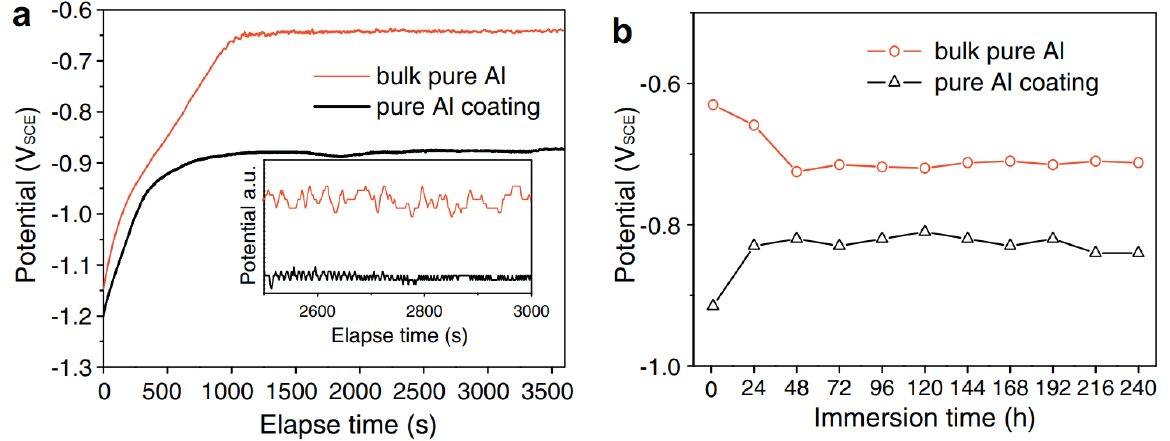
Figure 5. OCP vs. time curves for cold - sprayed pure Al coating and bulk pure Al in 3.5 wt.% NaCl solution in a time span ( a ) from 0 to 1 h (inset: from 2500 to 3000 s) and ( b ) from1 h to 10 days [49].